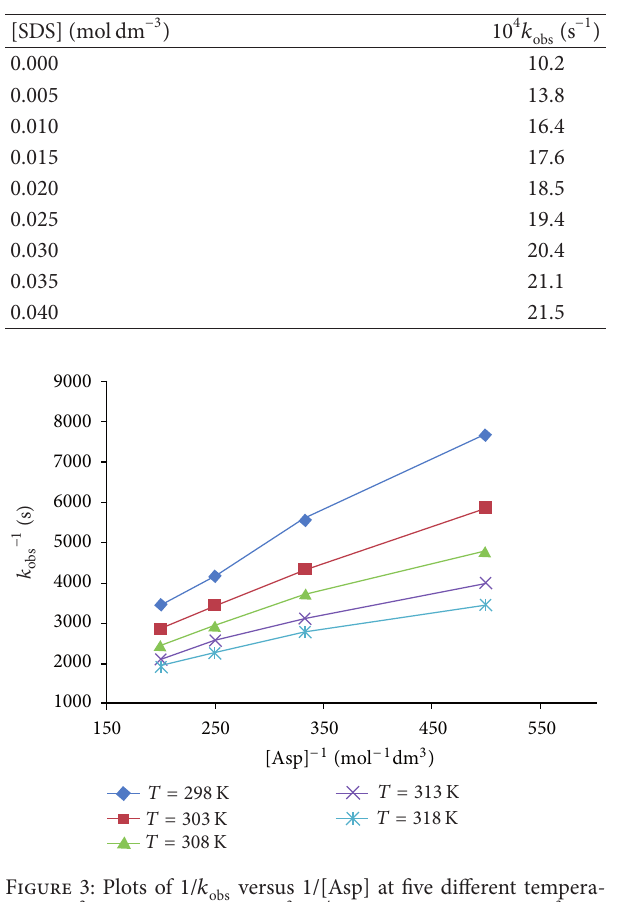
T 3: Effect of SDS on the oxidation of  -Aspartic acid by